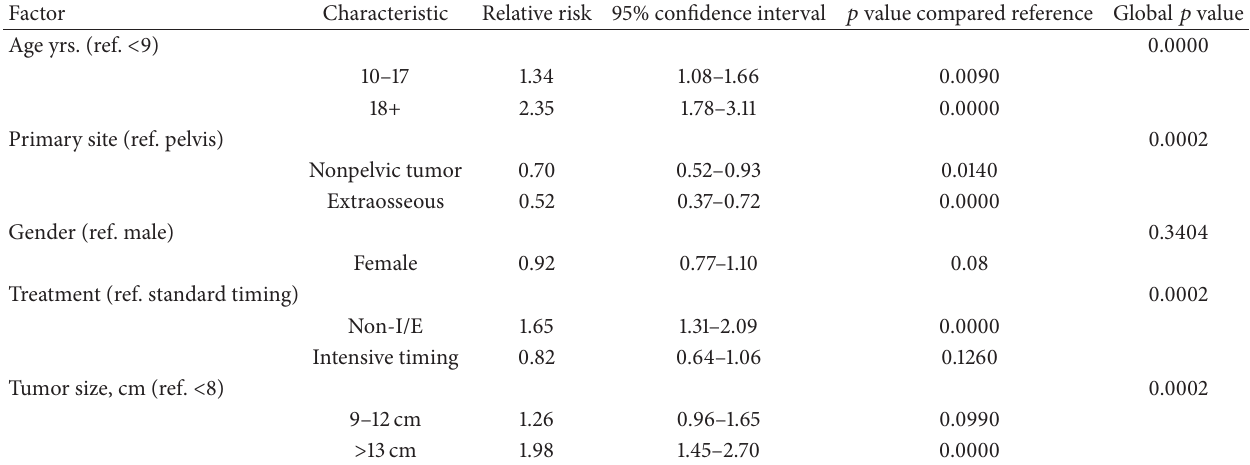
Table 3: Estimated risk coefficients on univariate analysis for 1444 patients treated in consecutive COG studies.